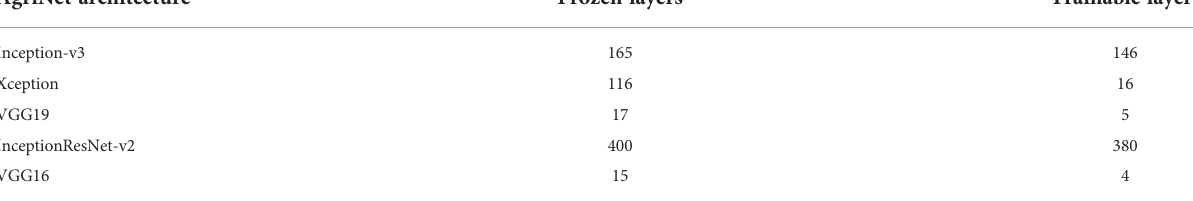
TABLE 3 Fine-tuning in agrinet models.